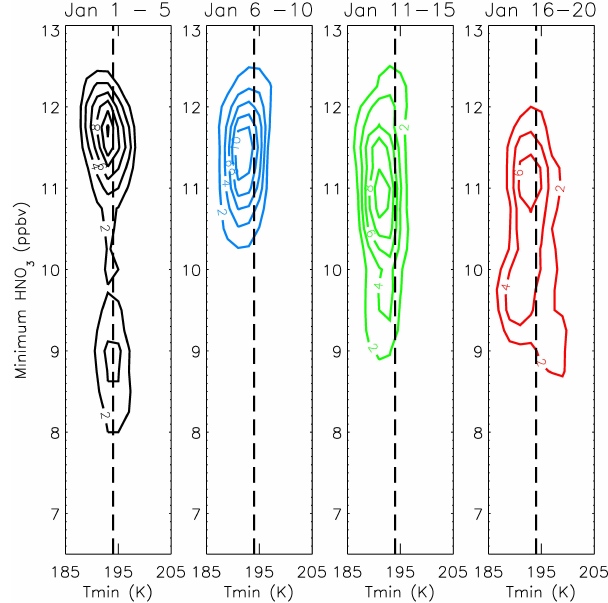
from each of the 5-day periods in Fig. 13. Points from each dis- tribution are binned according to intervals of 2K and 0.25ppbv HNO 3 , and their cumulative numbers are contoured at a spacing of 2. Dashed vertical line is for